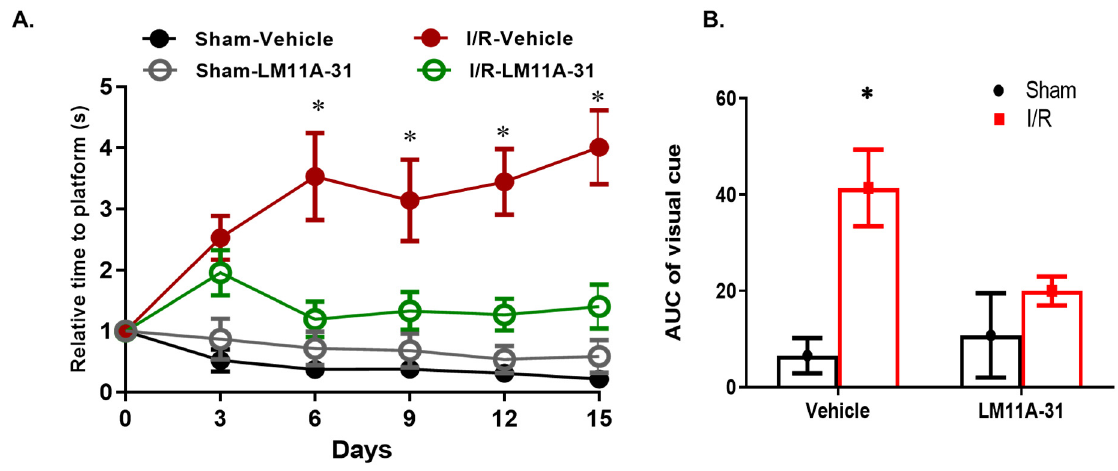
Figure 9. LM11A-31 improve visual acuity in WT mice post I/R injury. ( A ) Follow-up chart of visual-clue water-maze test showing relative time to reach the platform (seconds) for mice undergoing I/R injury and receiving LM11A-31 for up to 15 days post I/R injury. Mice subjected to I/R injury showed significantly longer time to reach the platform starting 6 days post I/R, that was attenuated in mice receiving LM11A-31. ( B ) Overall analysis of area under the curve (AUC) after 15 days of I/R experiment. Mice subjected to I/R injury showed significantly higher AUC, that was normalized in mice receiving LM11A-31. *, two-way ANOVA showed significant interaction of disease-state (ischemia) and treatment (LM11A-31) ( n = 7–9).